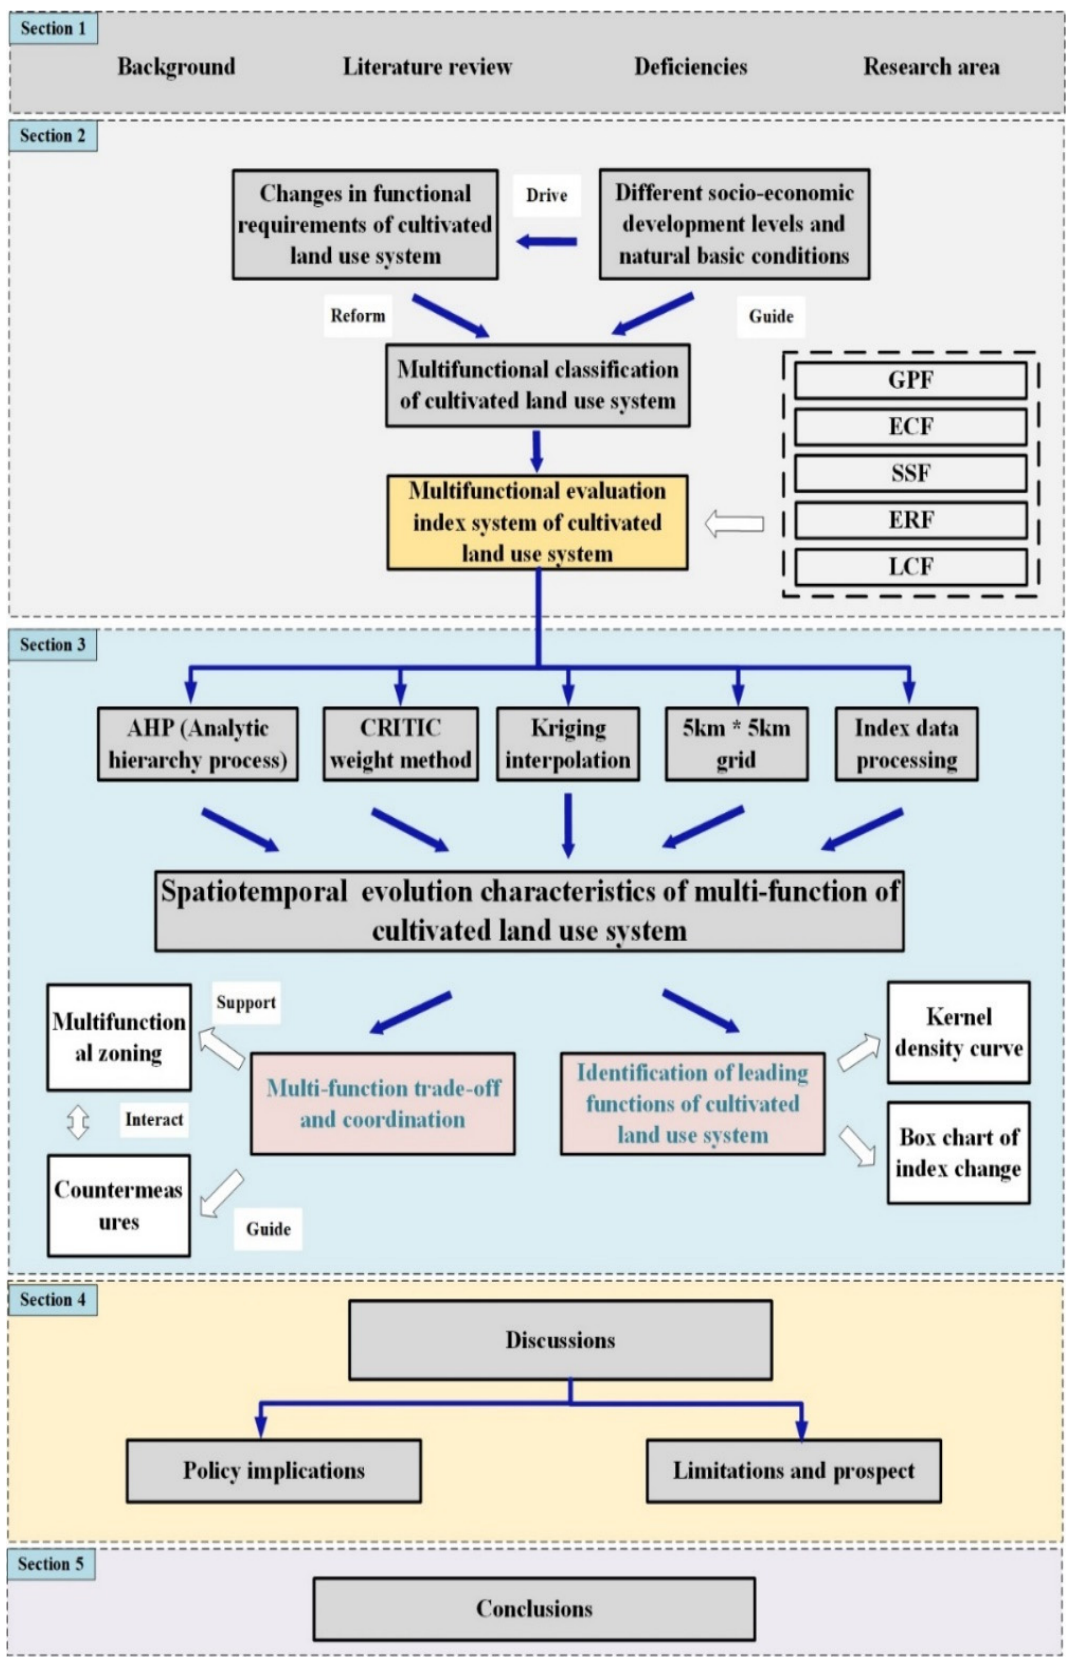
Figure 3. Technical roadmap for the multifunctional evaluation of cultivated land.